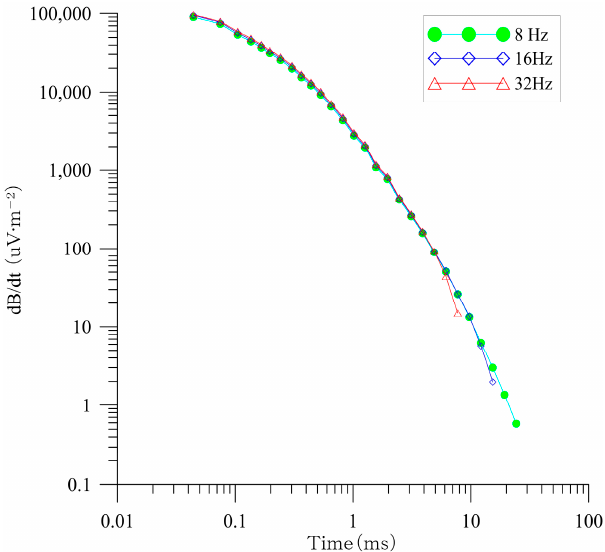
Figure 6. The decay curves of dB/dt at different frequency.